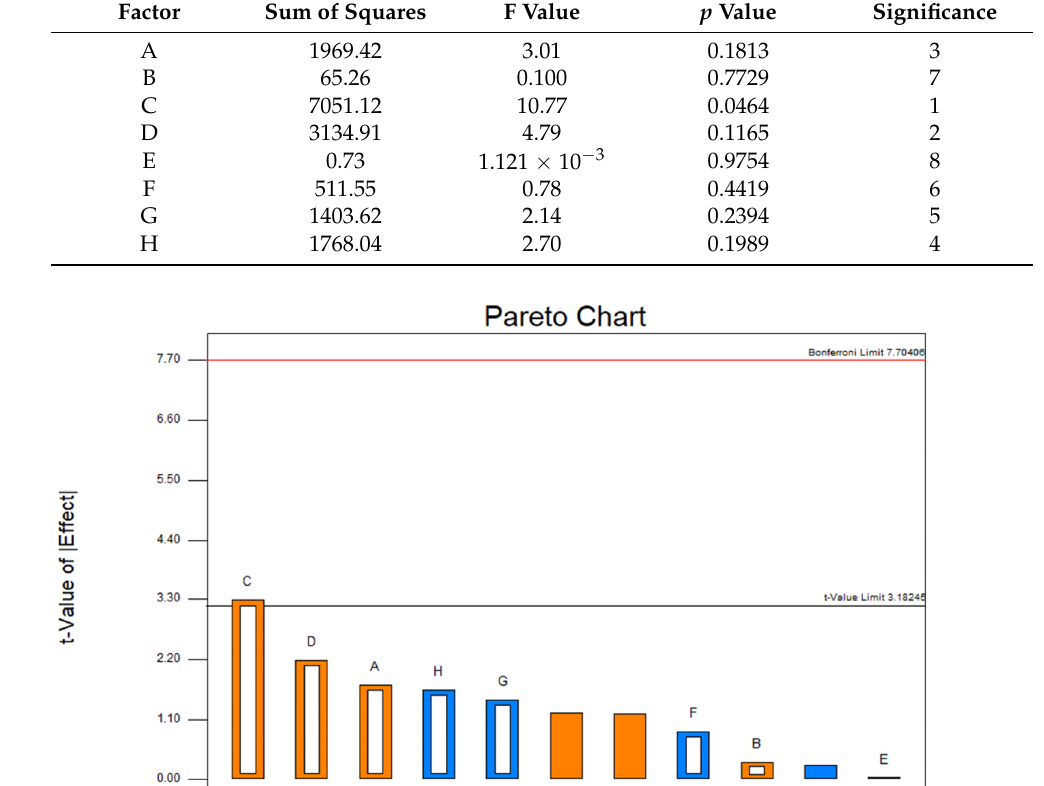
Table 10. Arrangement and results of the path of steepest ascent method.